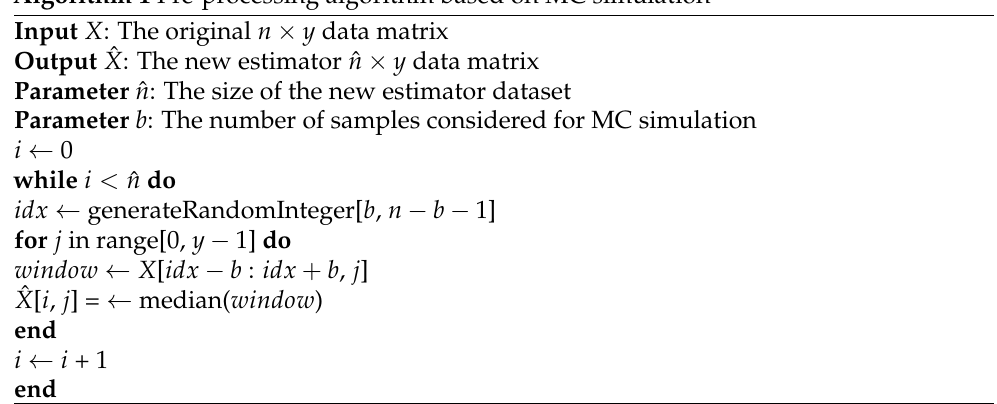
Algorithm 1 Pre-processing algorithm based on MC